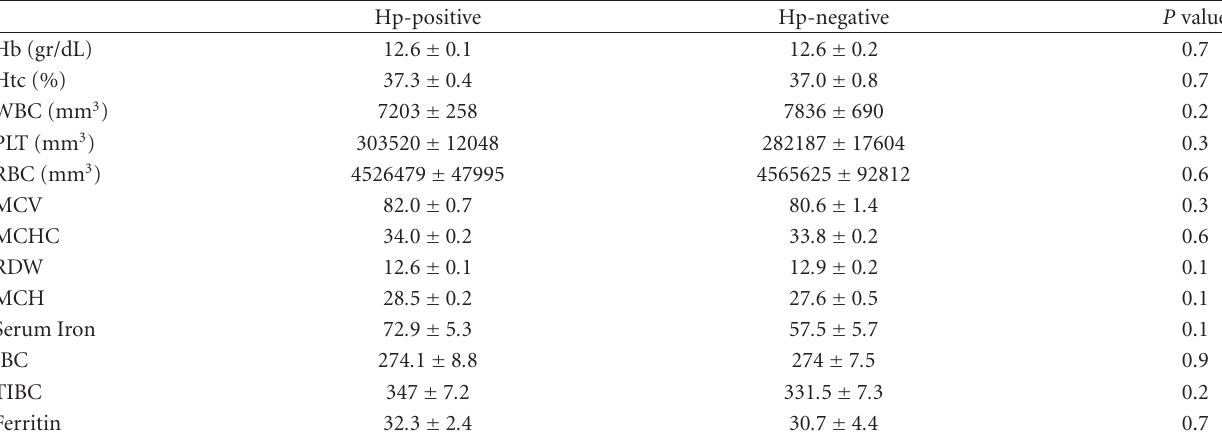
Table 3: Full blood count, serum iron, TIBC, and ferritin values of cases.